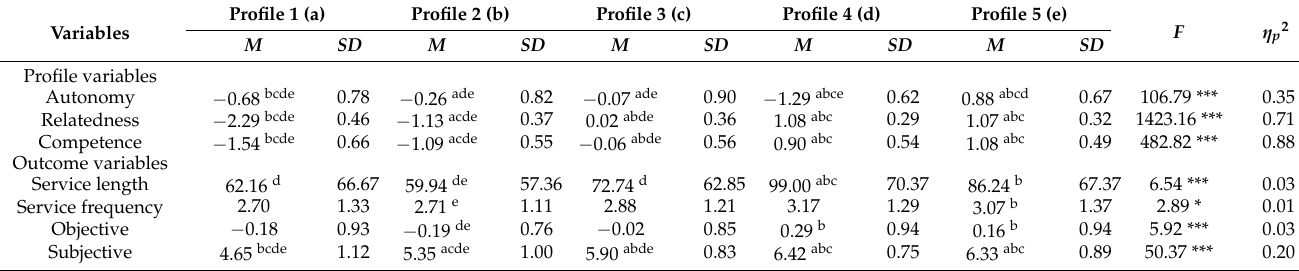
Table 2. Differences in mean scores for the three basic psychological need satisfaction (BPNS) and sustained volunteering.